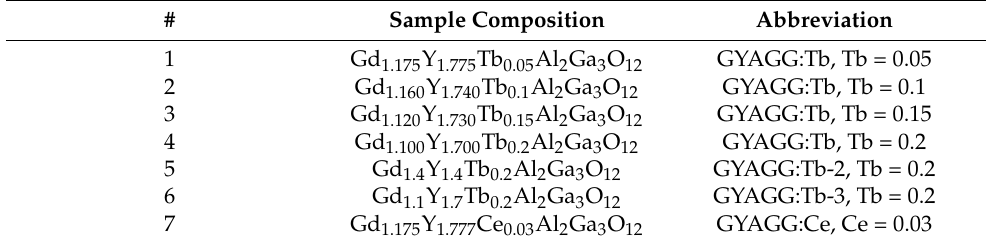
Table 1. Tb- and Ce-doped samples